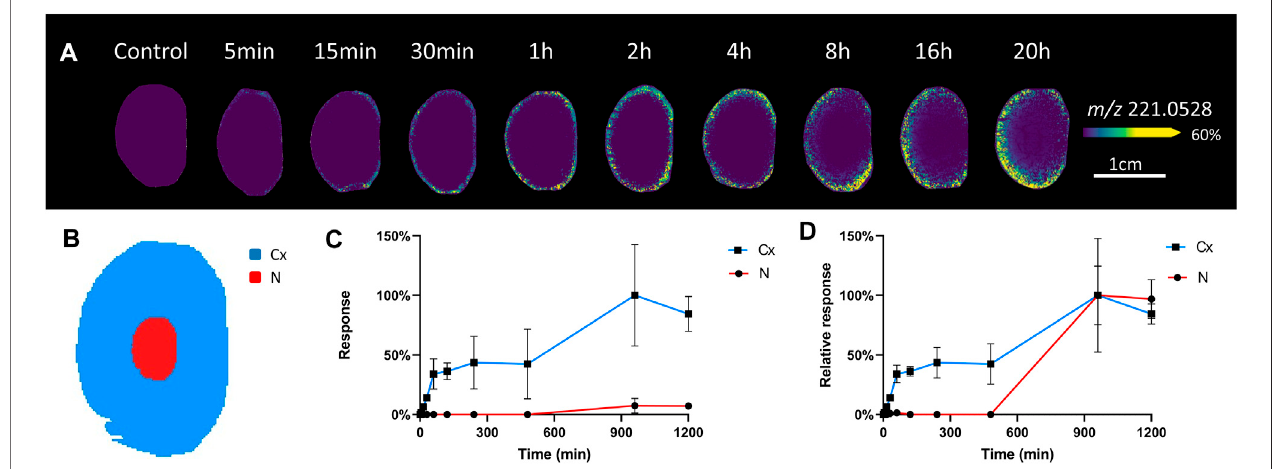
FIGURE2| VisualisationofSILglucoseuptakeinincubatedbovinelenses. (A) AseriesofMALDIimagesofaxialsectionstakenfrombovinelensesorganculturedin AAH containing 5 mM SIL glucose for 5 min to 20 h showing regional differences in SIL glucose ( m/z 221.0528) uptake. Control lenses incubated in normoglycaemic AAH containing non-labelled glucose showed no signal at m/z 221.0528. Lenses orientated with anterior surface to the right. (B) Schematic diagram indicating the two regions [cortex (Cx) = blue, nucleus (N) = red] from which SIL glucose signals were extracted for relative quanti fi cation and comparison. Relative intensity plots of m/z 221.0528 from each lens region showing signal increase over time normalised to maximal signal in the dataset. (C) , and to maximal signal within each lens region (D)